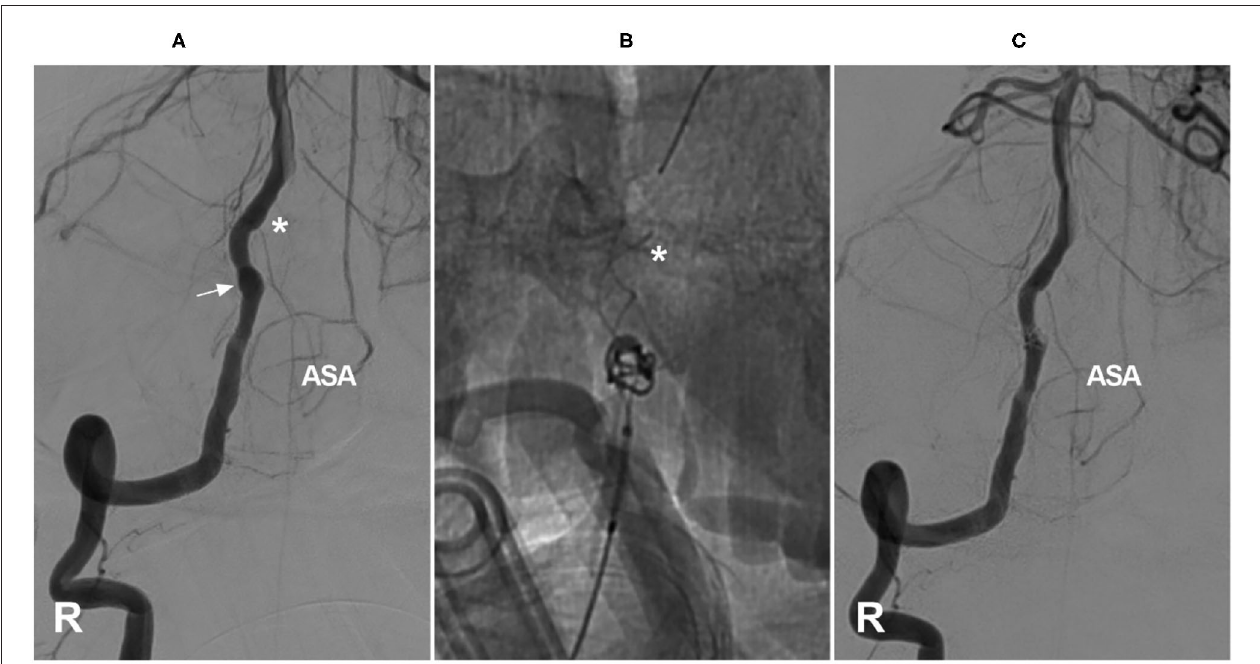
FIGURE 5 | Coverage of the ASA ostia after coiling with stent assistance for an aneurysm. (A) Right VA angiogram showing the dissecting aneurysm (arrow) and the ASA (the asterisk indicates its origin). (B) The aneurysm was coiled with Leo stent assistance, and the tip of the stent covered the ASA ostia (asterisk). (C) After coiling, the ASA had normal blood flow. ASA, anterior spinal artery; R, right; VA, vertebral artery.